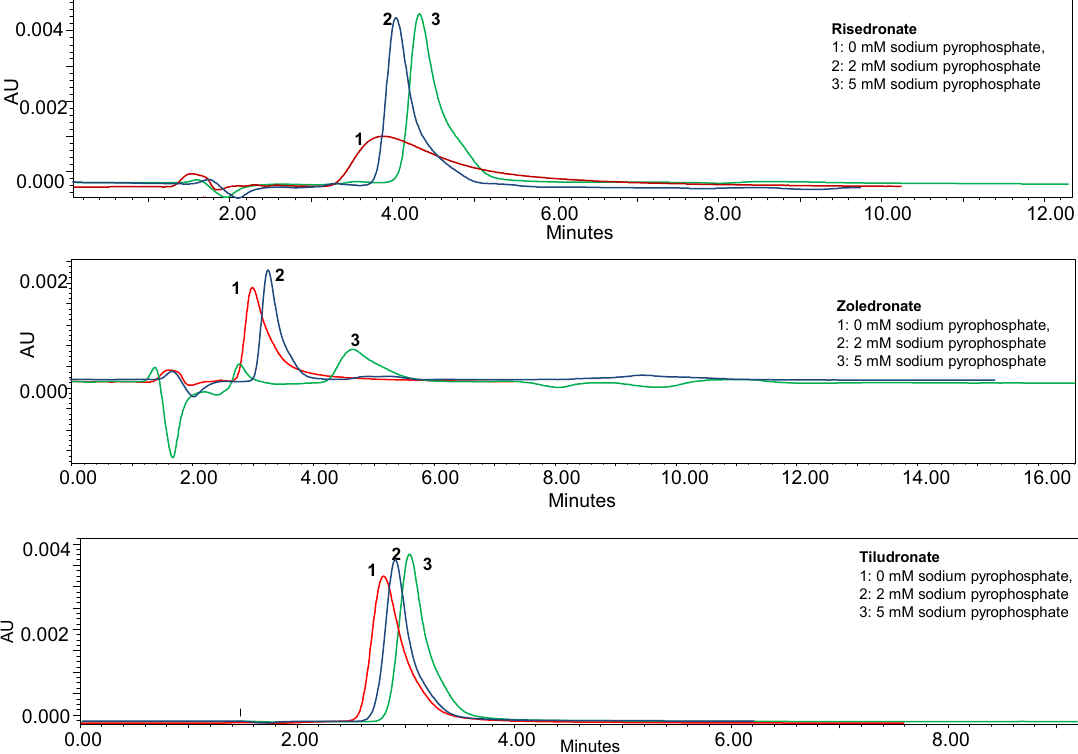
Figure 3. Typical HILIC chromatograms showing the effect of sodium pyrophosphate concentration (mM) on the on the retention time and the peak shape of bisphosphonates. Chromatographic conditions: ZIC®-pHILIC analytical column, mobile phase: acetonitrile–10 mM ammonium acetate aqueous solution pH 6.8 (65:35, v / v ), flow rate of 0.25 mL min −1 and UV detection at 262 nm.